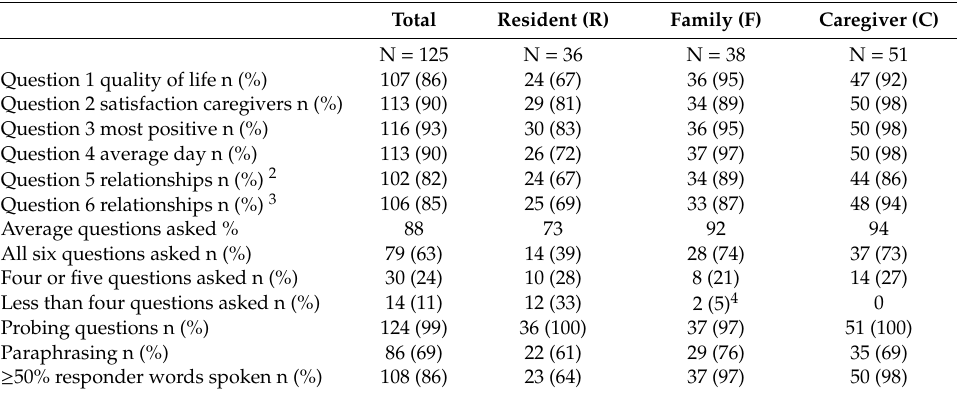
Table 4. Protocol adherence results 1